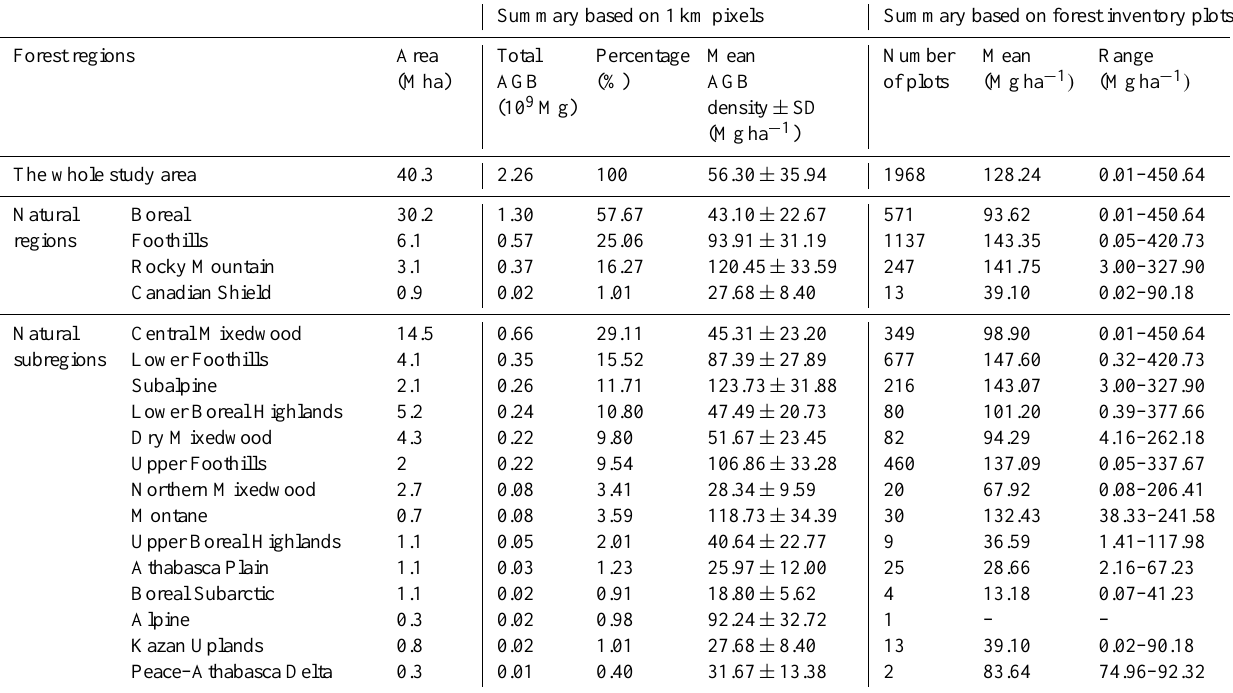
Table 3. Total tree AGB estimated by decision-tree-based modeling with random forests algorithm in different natural regions and subregions in Alberta forests. Summary based on 1km pixels Summary based on forest inventory